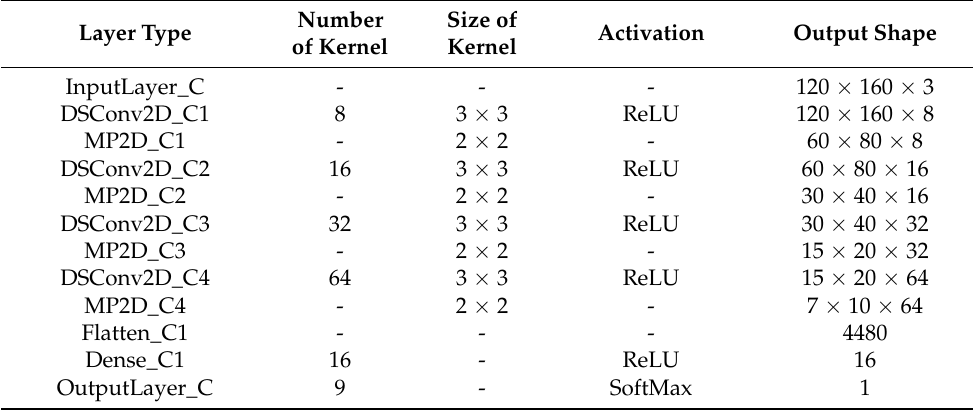
Figure 4. The detailed structure of the DIC model of the proposed method. Table 4. The detailed structure of the DIC model.